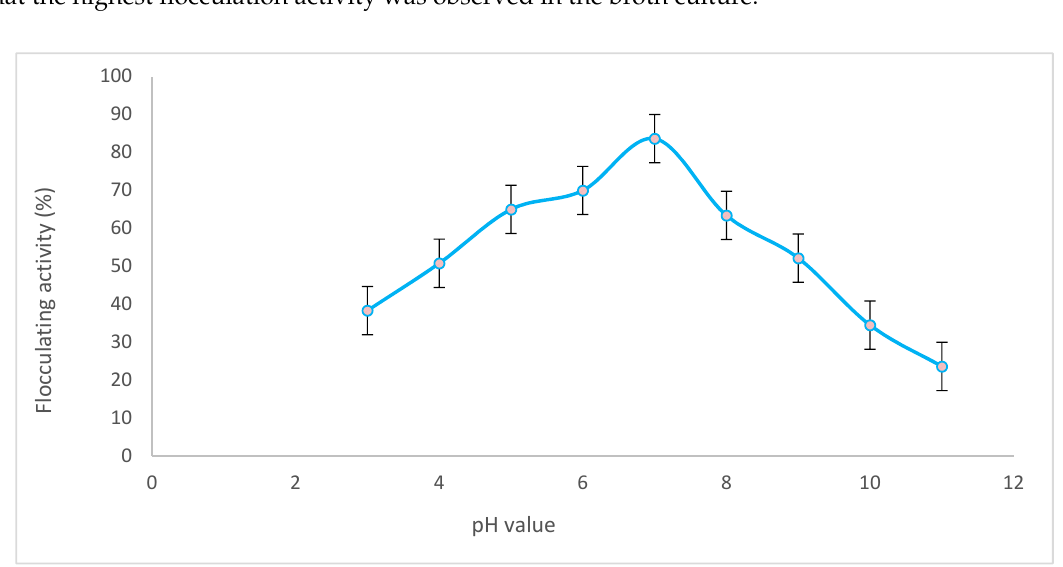
Figure 1. Effect of pH on bioflocculant production.